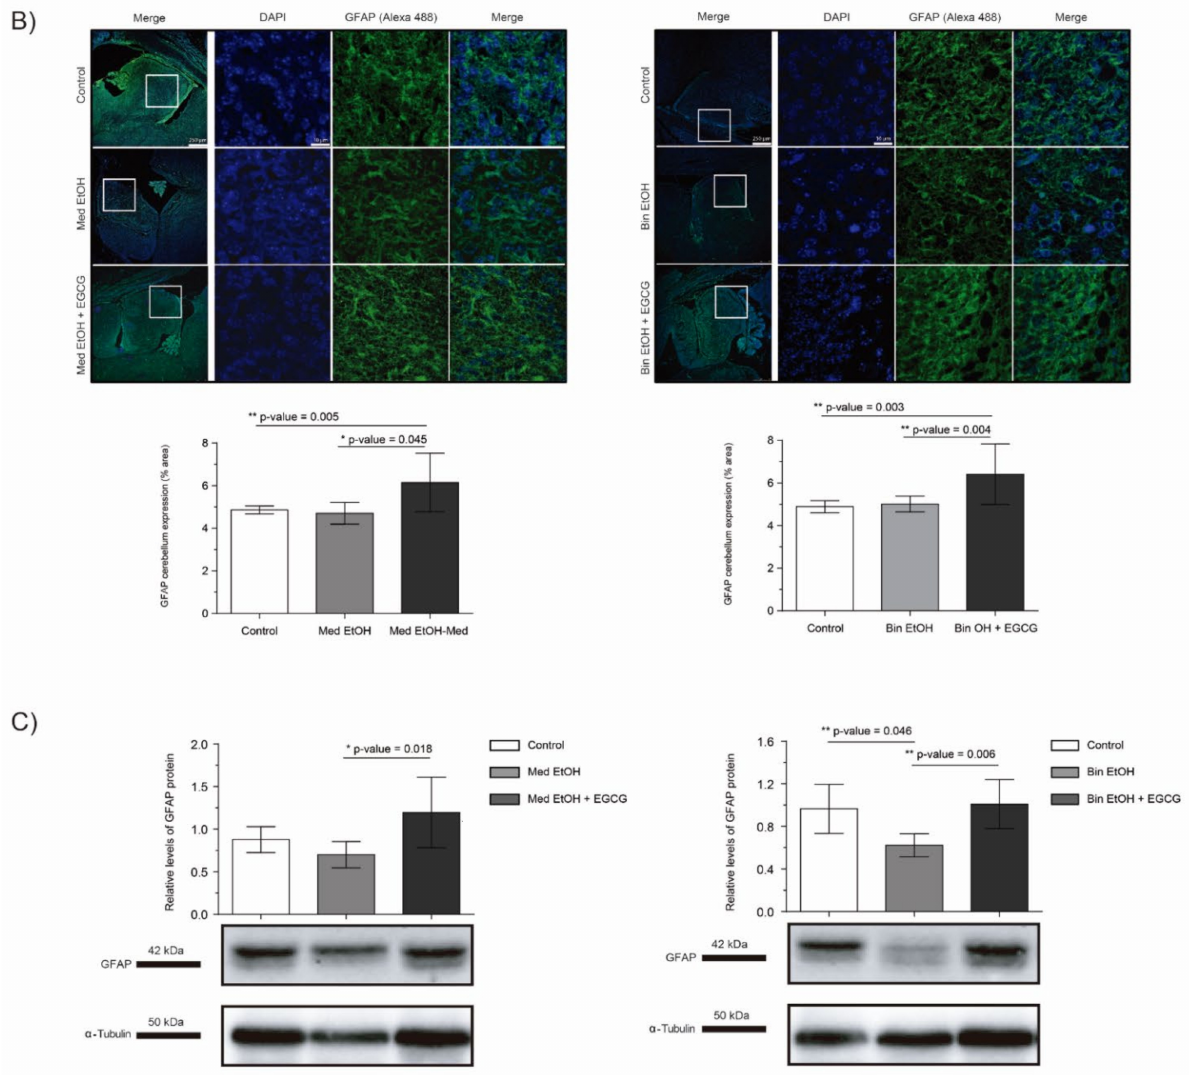
Figure 8. Glial fibrillary acidic protein (GFAP) immunofluorescence (Alexa 488 in green for the GFAP biomarker and DAPI to stain the nuclei in blue) in the hippocampus ( A ) and cerebellum ( B ). Boxed regions in hippocampus and cerebellum are shown at higher magnification using 63 × Oil Immersion. Glial fibrillary acidic protein analysis in brain lysed samples ( C ) for PAE and EGCG treatment under the selected experimental conditions. ( A ) GFAP quantification in whole sections of the dentate gyrus using a 10 × objective lens. ( B ) GFAP quantification in whole sections of the cerebellum using a 10 × objective lens. ( C ) Representative Western blot of GFAP expression analyzed under the various experimental conditions. Protein levels were normalized using α -tubulin as load control. Arbitrary units express “fold change”. At least five samples from different litters were used from each group. For intergroup comparisons, the Kruskal–Wallis test (Dunn’s test for multiple comparisons) was used. Asterisks denote the level of significance: * p -value < 0.05, ** p -value < 0.01.